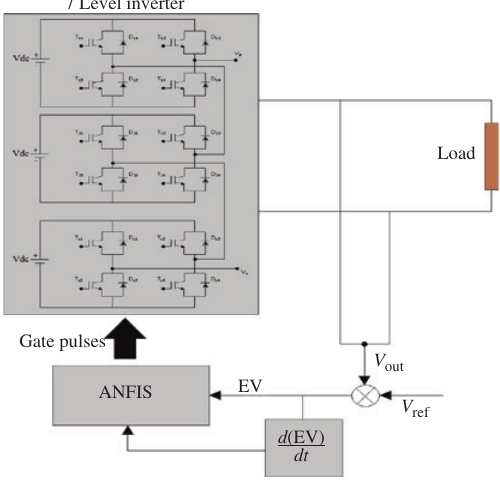
Figure 1: Structure of the Proposed